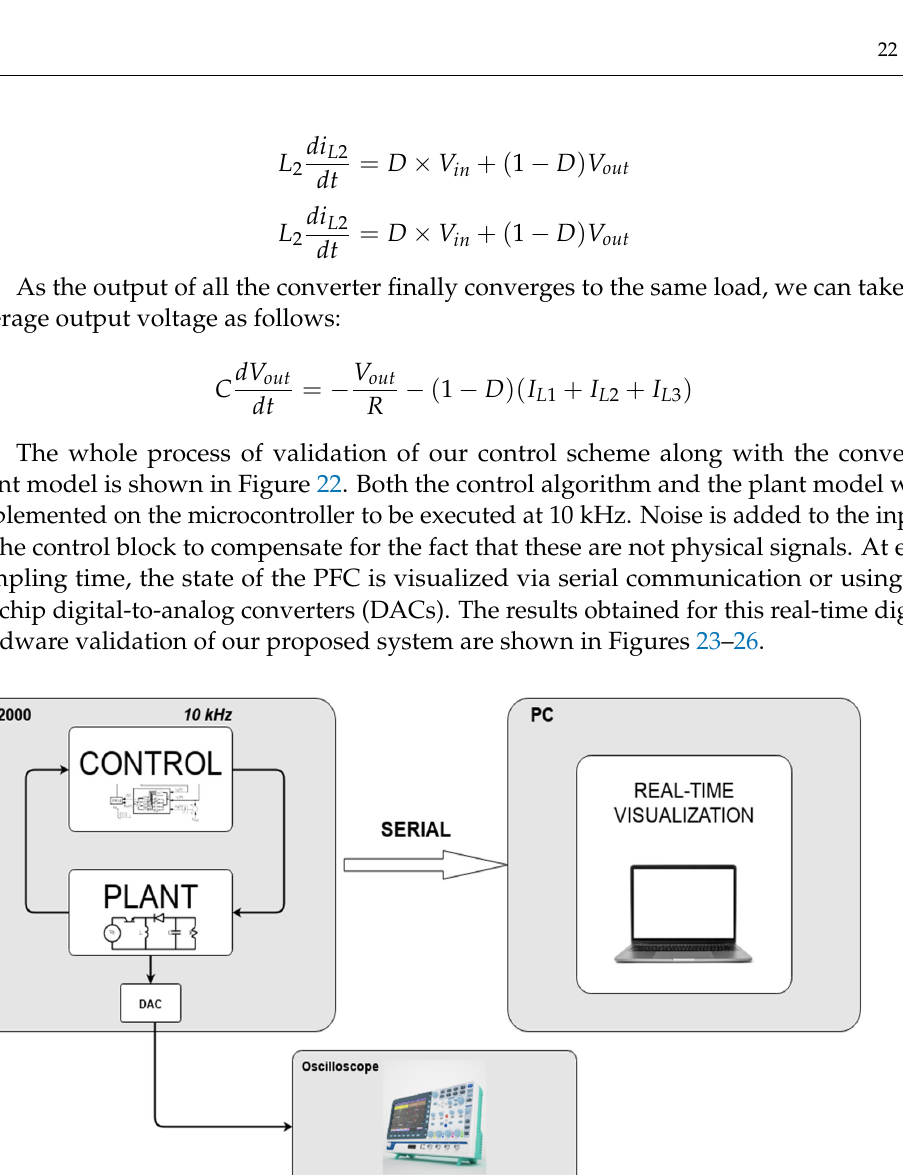
Figure 24. Inductor (1st and 3rd) current profiles for different inductor values of converters.